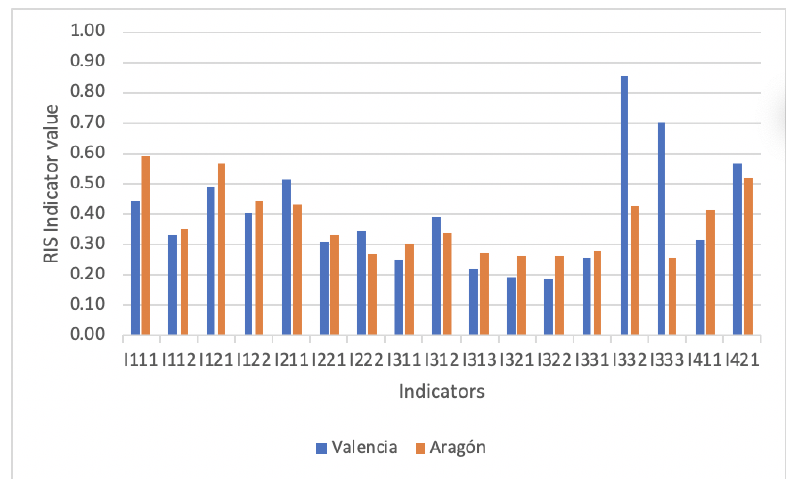
Figure 3. RIS indicators for (ES52) Comunidad Valenciana and (ES24) Aragón. The indicators are denoted as shown in Table A1.